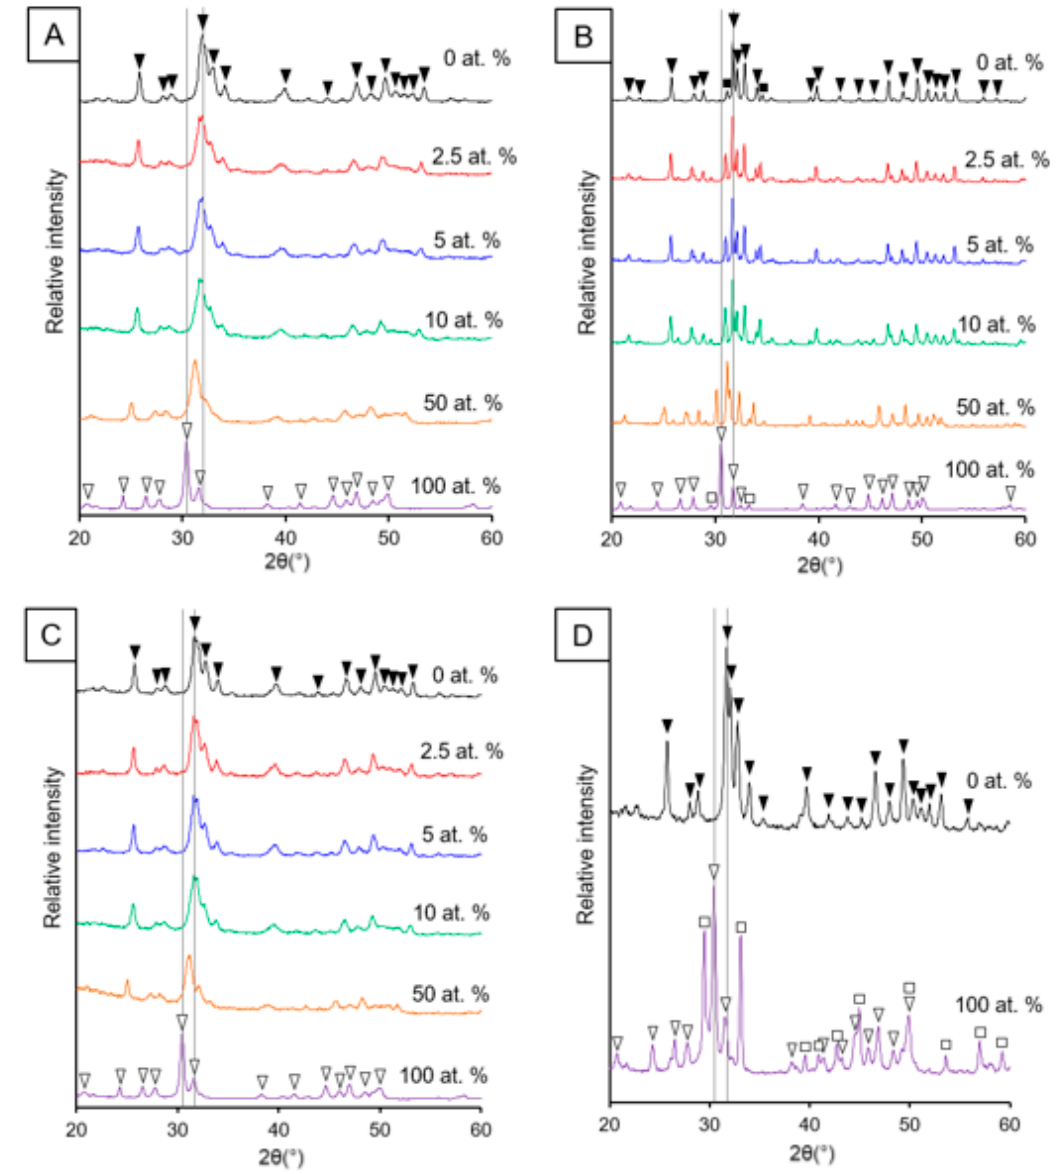
Figure 1. XRD patterns of SrHA powders (0, 2.5, 5, 10, 50 and 100 at.% Sr) produced using wet precipitation ( A , B ) and sol-gel ( C , D ) methods. Unsintered powders ( A , C ) and powders sintered at 1000 °C ( B ) and 700 °C ( D ). Peak labels: hydroxyapatite;